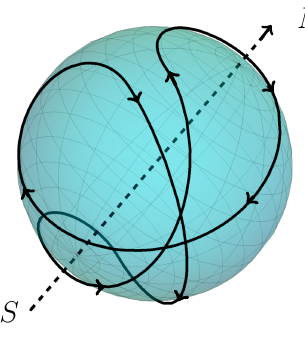
Figure 1 . The Pochhammer loop on the Riemann